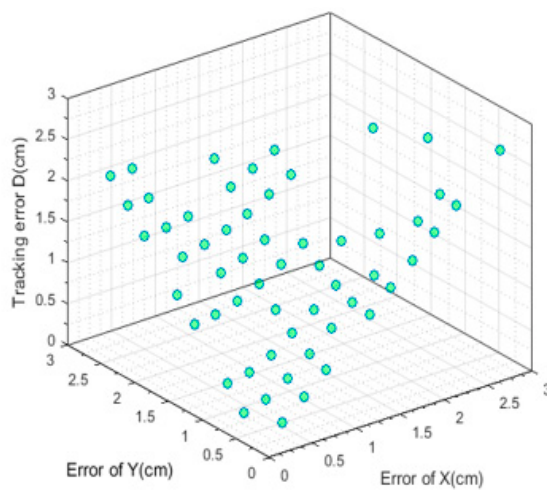
Figure 20. The error under the situation where random areas of the LED was shielded.